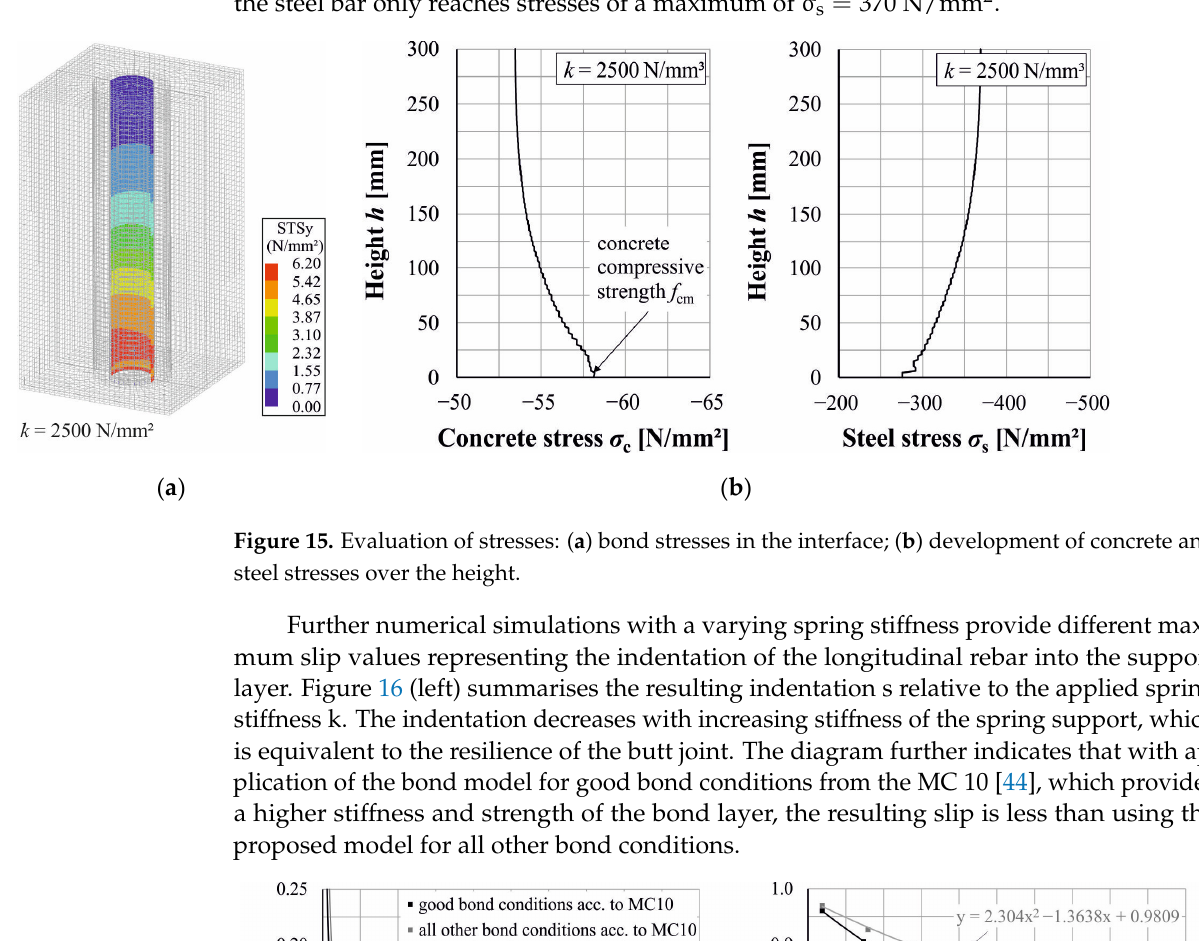
Figure 14. ( a ) FE model of reinforced concrete member with elastic spring support; ( b ) vertical deformation plot.